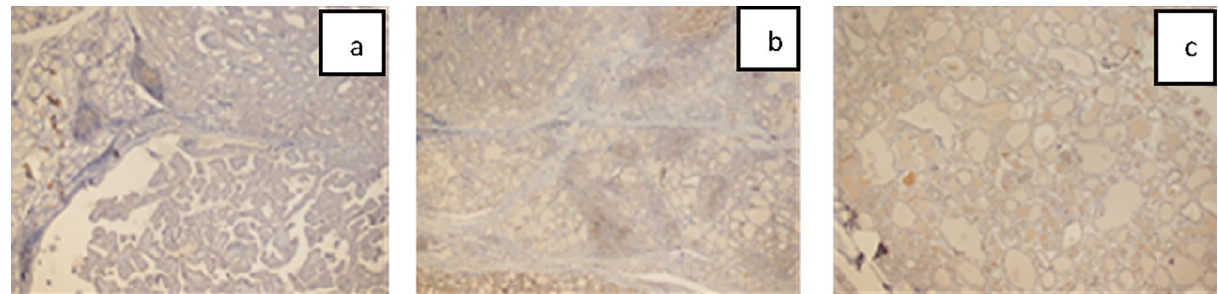
Figure 3. ( a ) MLH1 immunoreactivity PTC (× 4). ( b ) MLH1 immunoreactivity Chronic thyroiditis (× 4). ( c ) MLH1 immunoreactivity Nodular colloidal goiter (× 4).